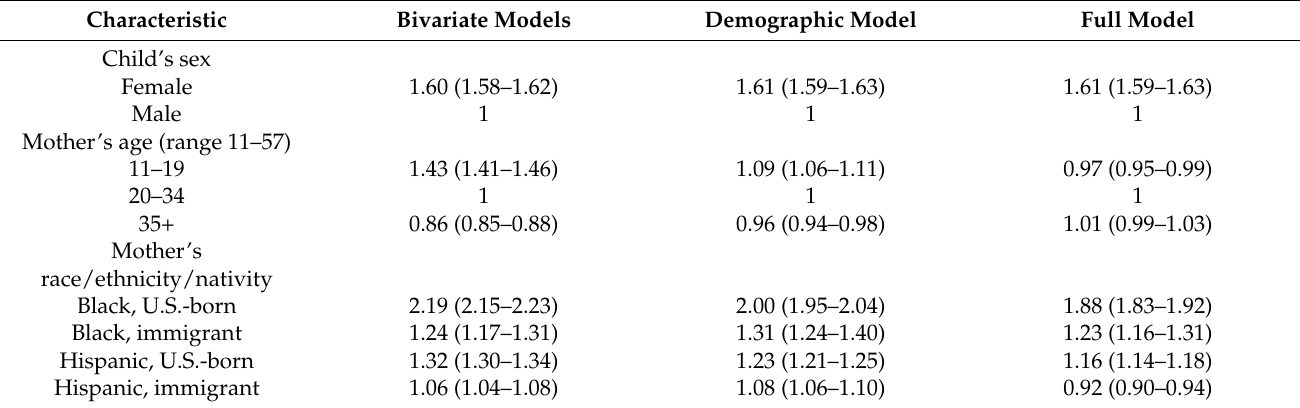
Table A2. Odds and 95% confidence intervals of small-for-gestational age, 2009–2011 Texas natality files, n =